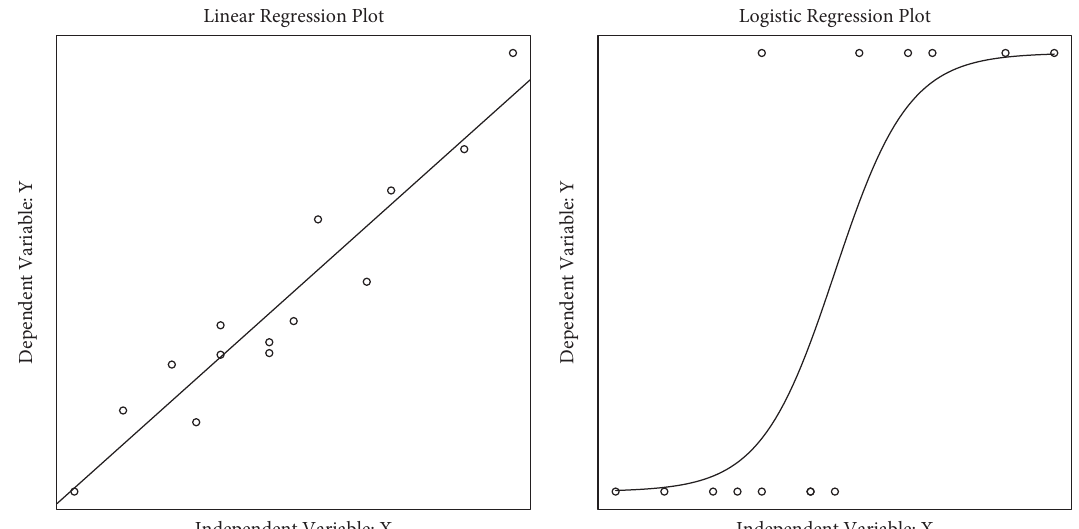
Figure 1: (a) Regression plots from linear regression analysis (left) and (b) logistic regression analysis (right) with one continuous in- dependent variable. Table 2: Results from a study of risk factors associated with hyperglycemia using binary logistic regression analysis [14]. Independent